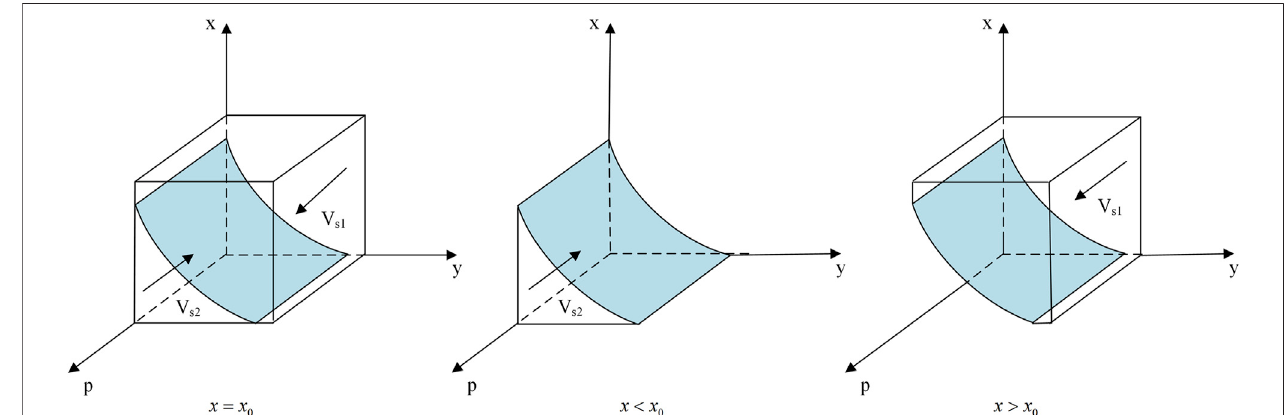
FIGURE 4 | The strategic choices of online